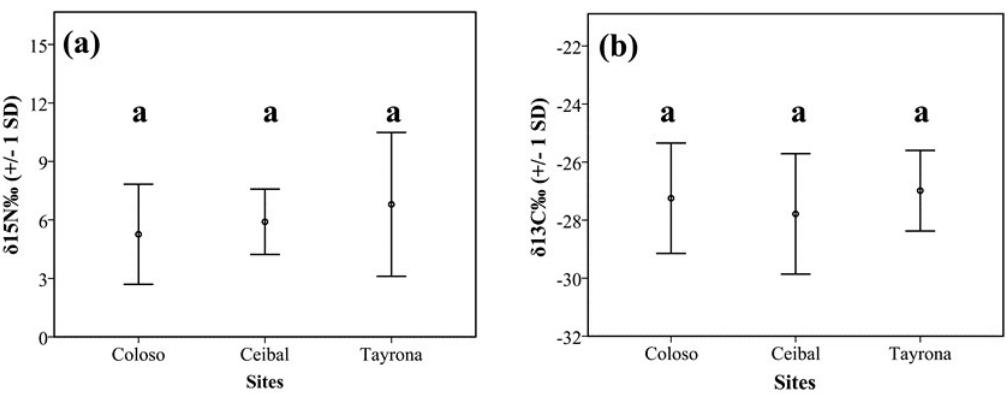
Figure A3. Boxplot showing mean values for ( a ) δ 15 N‰ and ( b ) δ 13 C‰ +/− 1 SD for soil between sites. Soil samples did not differ significantly between sites for δ 15 N‰ (ANOVA: F 2, 12 = 1.55; p = 0.253) and δ 13 C‰ (ANOVA: F 2, 12 = 1.01; p = 0.391).